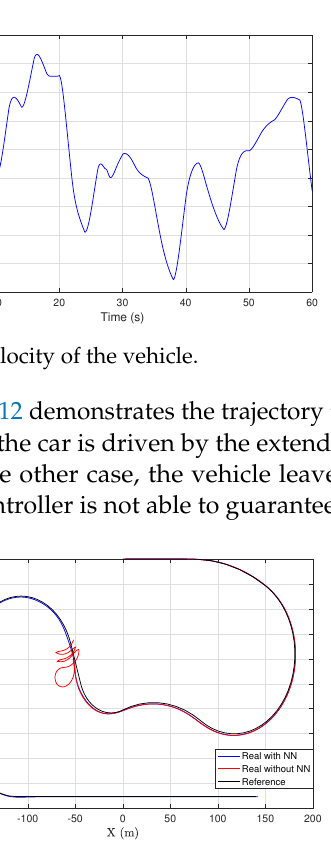
Figure 12. Path of the vehicles during the simulations.